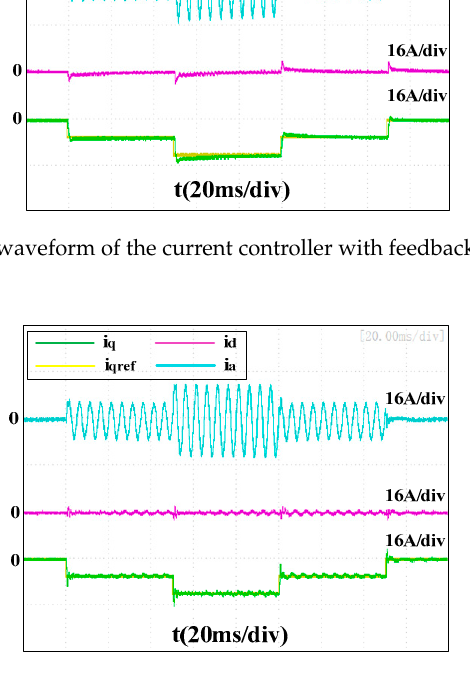
Figure 22. d-q axis current waveform of the proposed accurate discrete current controller at 12,000 rpm with Kdq = 1000 π Ls.